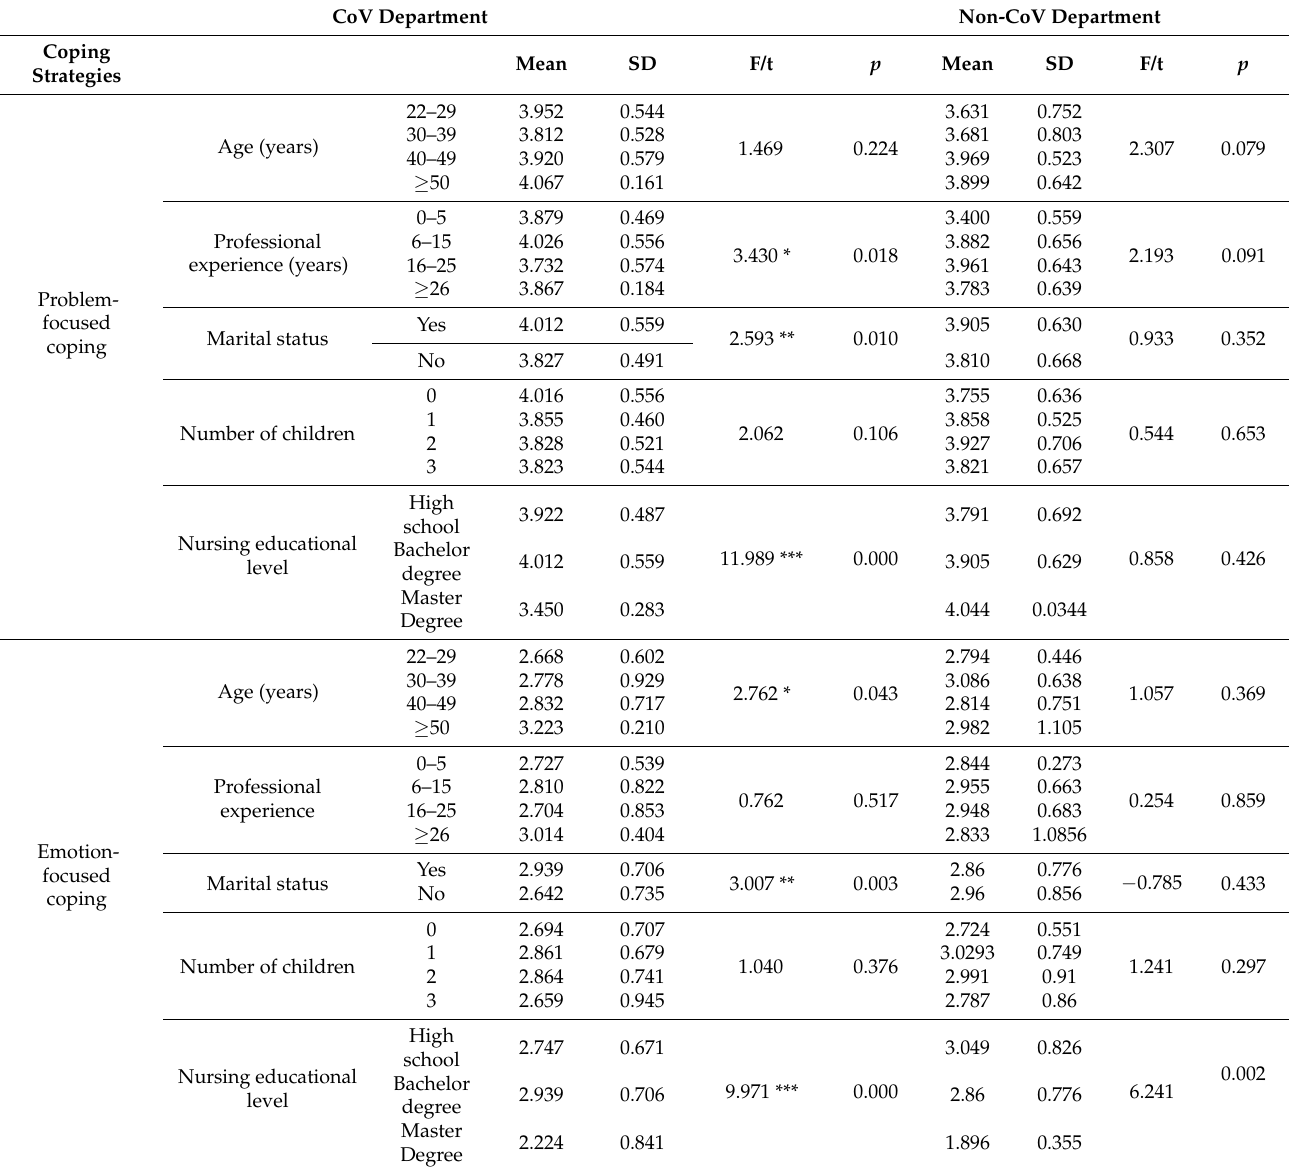
Table 2. Differences in coping strategies regarding sociodemographic characteristics in CoV and non-CoV